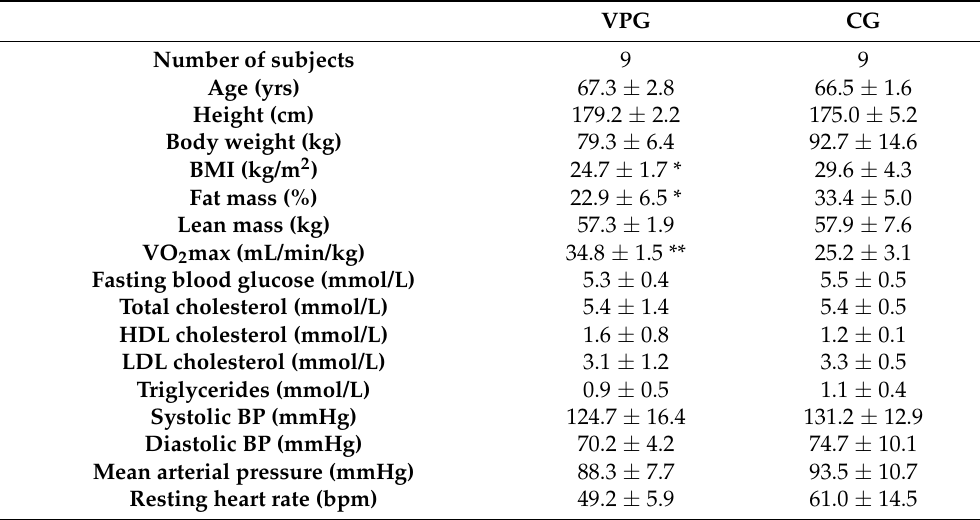
Table 1. Anthropometric, biochemical and clinical parameters of the subjects participating in the